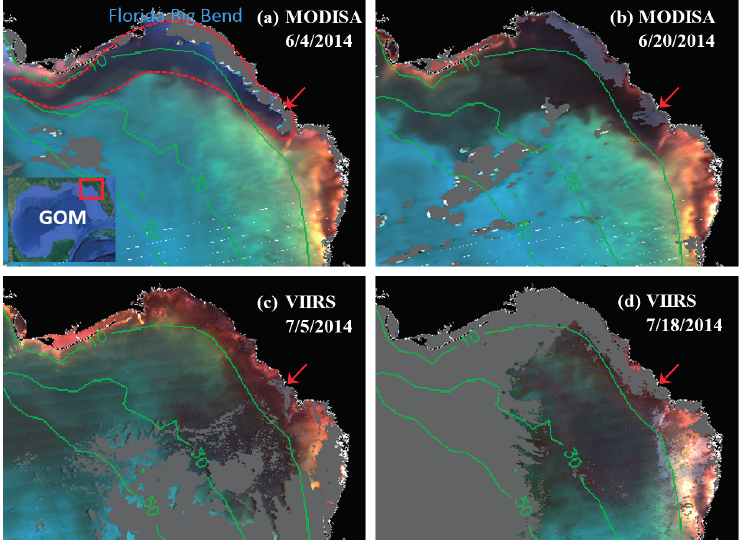
Figure 2. ( a – d ): MODIS and VIIRS ERGB images showing the progression of a dark water event off Florida’s Big Bend region. The dark water in ( a ) is outlined approximately with the red dotted line. Annotated are the water depth contour lines in meters. The images cover 28°–30.2°N, 85.5°–82.5°W. The location of the Suwannee River mouth is annotated with red arrows. Gray represents clouds or invalid